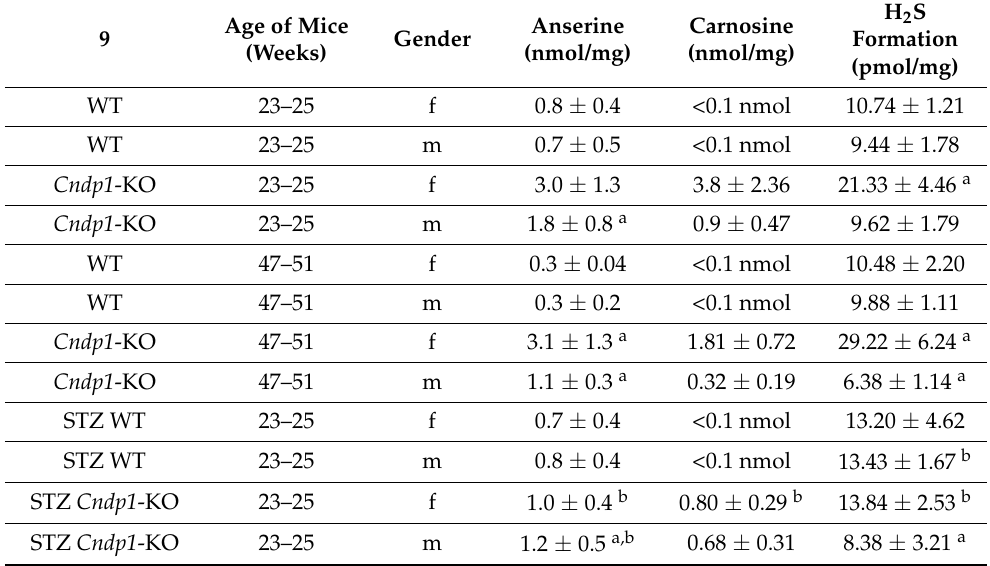
Table 1. Renal anserine and carnosine concentrations in kidney tissue of WT and Cndp1 -KO mice (n =